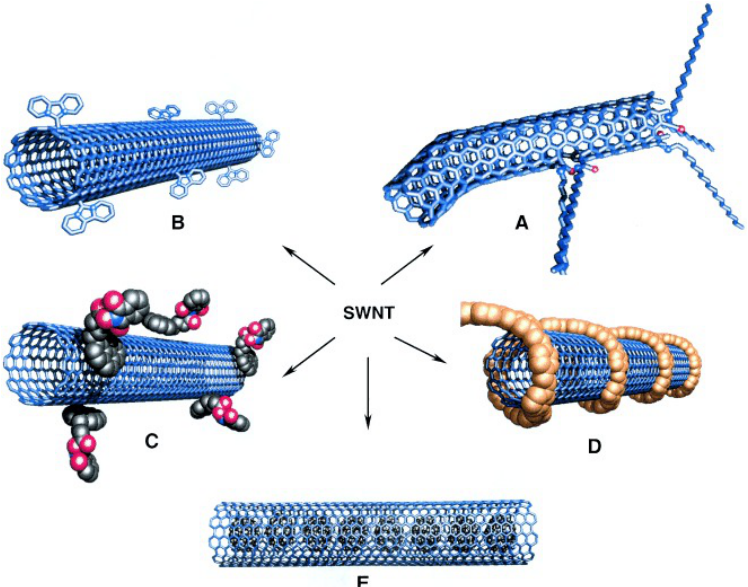
Figure 11. Functionalization possibilities for SWNTs: ( A ) defect-group functionalization, ( B ) covalent sidewall functionalization, ( C ) noncovalent exohedral functionalization with surfactants, ( D ) non- covalent exohedral functionalization with polymers, and ( E ) endohedral functionalization with, for example, C 60 . For methods B-E, the tubes are drawn in idealized fashion, but defects are found in real situations. Reprinted with permission from Ref.